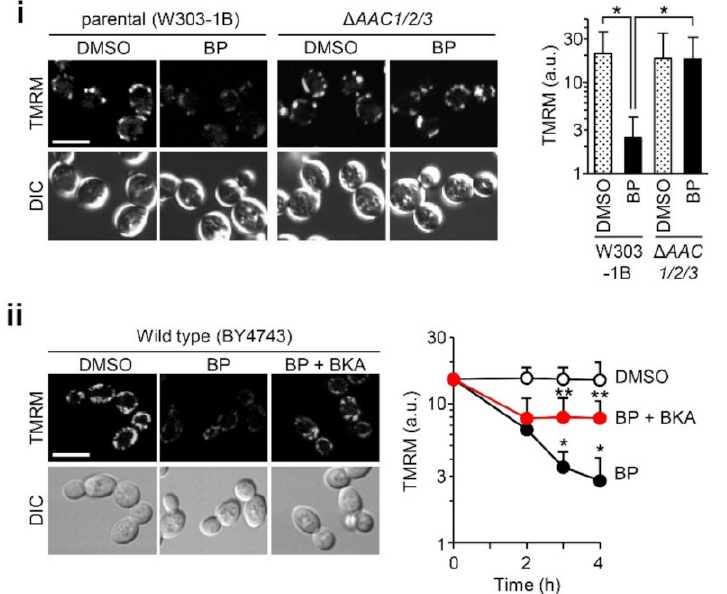
Figure 3. The involvement of AACs in BP-induced mitochondrial depolarization. ( i ) Yeast strains of the parental type (W303-1B) and deficiency of all three AACs ( ∆ AAC1 / 2/3 ) were treated with BP for 4 h. TMRM fluorescence images at 4 h (left panel) and quantification (right panel) (error bars represent the mean ± SD from 100–150 cells; * p < 0.001). ( ii ) BY4743 cells were treated by BP with or without 10 µ M bongkrekate (BKA), a specific AAC inhibitor. Confocal images at 4 h (left panel) and their time courses over 4 h (right panel: data represent the mean ± SD from 100–150 cells; * p < 0.001 relative to DMSO control; ** p < 0.01 relative to BP at the same time points). The experimental conditions are shown in Figure 1. Scale Bars: 5 µ